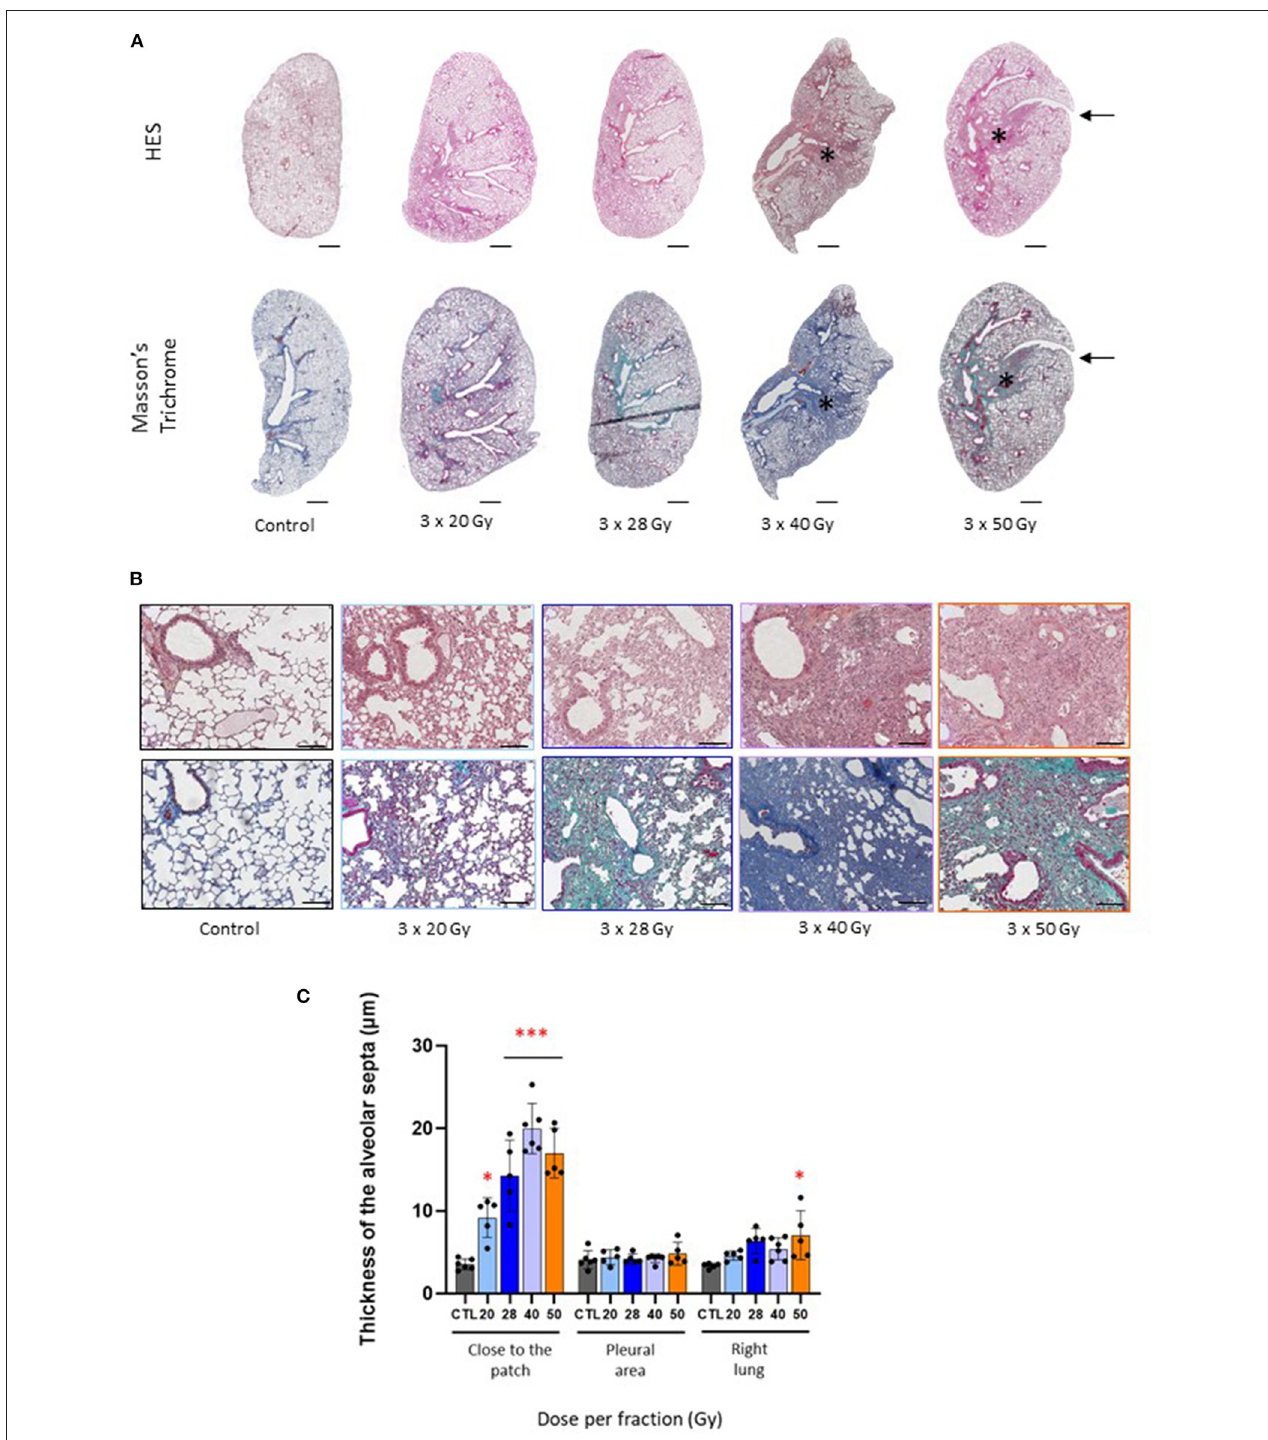
FIGURE 2 | Fraction size of 40Gy or higher generates lung tissue fibrosis after 6 months. (A) Images of HES and Masson’s trichrome stained control and focally irradiated left lungs 6 months following 3 × 20, 28, 40 or 50Gy. Asterix and arrows indicate radiation-induced fibrosis and stricture, respectively. Scale bar represents 1mm. (B) Details of lung parenchymal damage induced by 3 × 20, 28, 40, and 50Gy either following HES (upper line) or Masson’s Trichrome staining (lower line). Scale bar represents 200 µ m. (C) Thickness of the alveolar septa was measured close to the injury patch, far from the patch (near the pleura) and in the right lung 6 months following focal exposure to 3 × 20, 28, 40 or 50Gy. Measurements were performed in corresponding areas for control tissues. * p < 0.05; *** p < 0.001 compared to control group. n = 5 or 6 per group.